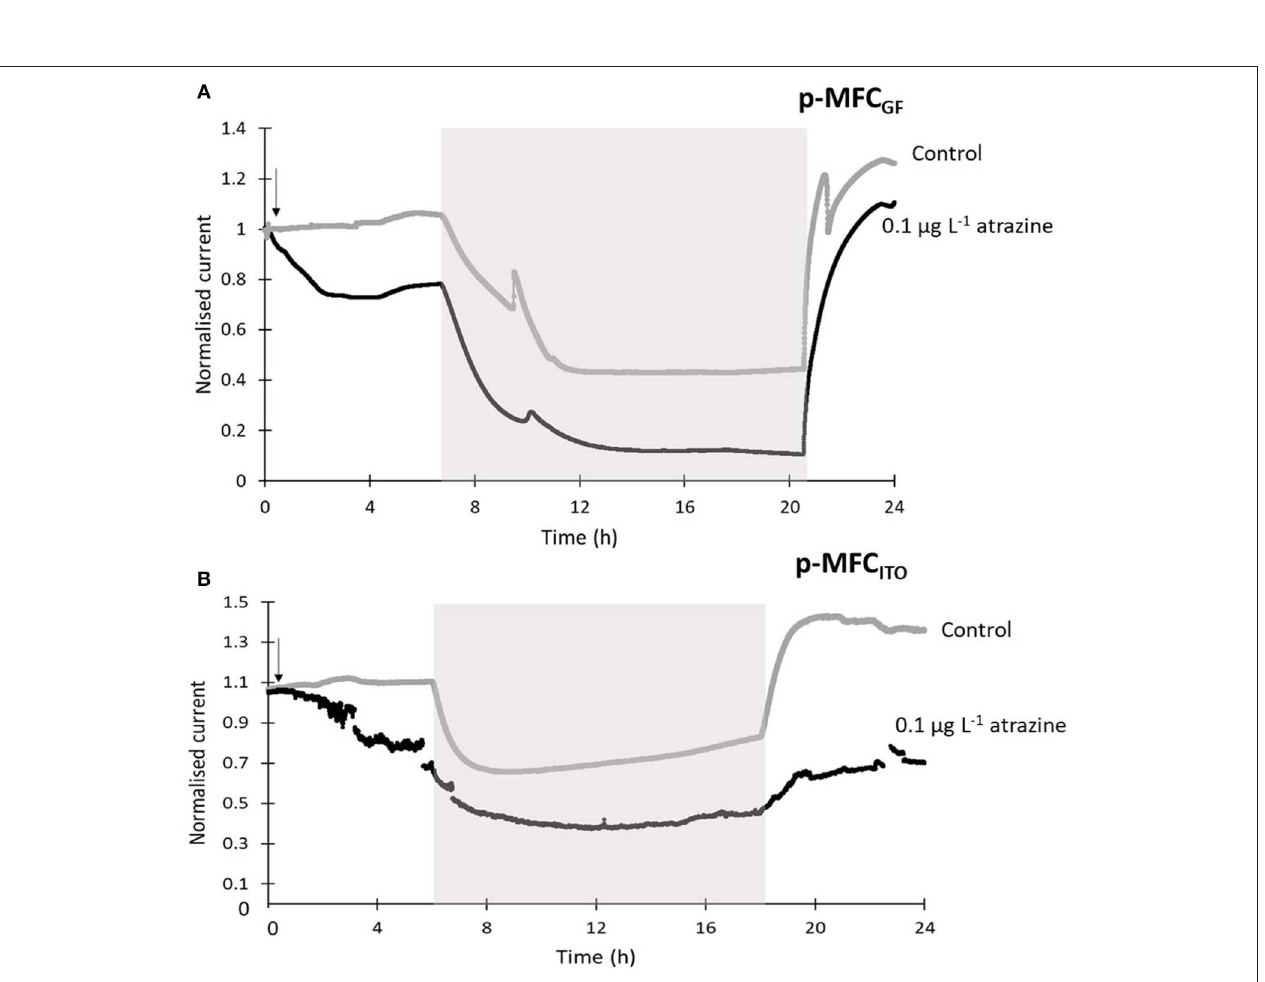
FIGURE 4 | Sensors response to 0.1 µ g L − 1 of atrazine for p-MFC GF (A) and p-MFC ITO (B) during the first 24h after intoxication. The current output was normalized by the baseline current before the injection, I b . Black lines correspond to the fuel cells exposed to atrazine and gray lines correspond to the control p-MFCs. The arrow indicates the point of atrazine injection. Error bars (referring to two replicates) are presented in Figure S12 . Shadowed areas indicate the operation during the dark cycle.